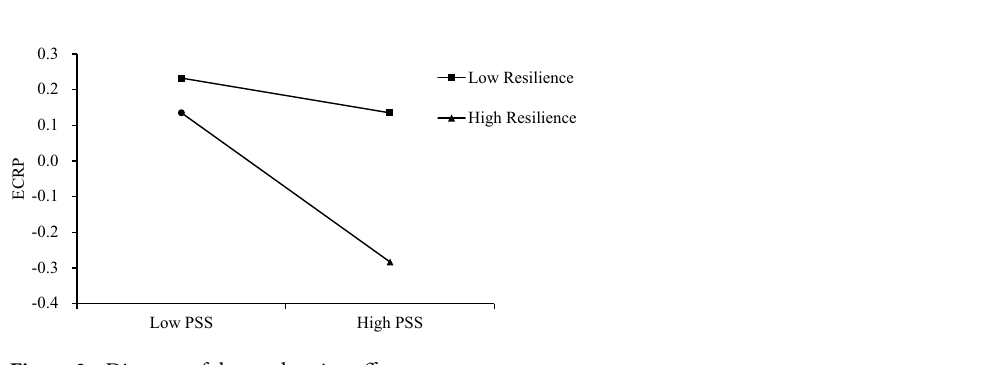
Figure 2. Diagram of the moderating